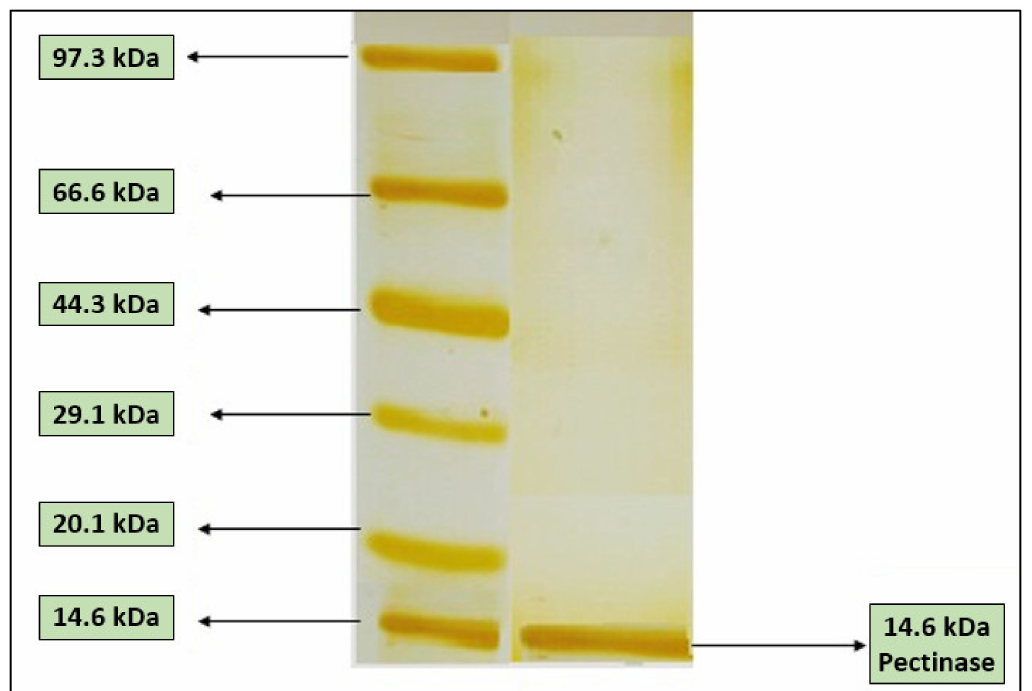
Figure 3. SDS PAGE pattern of purified pectinase purified from Bacillus subtilis